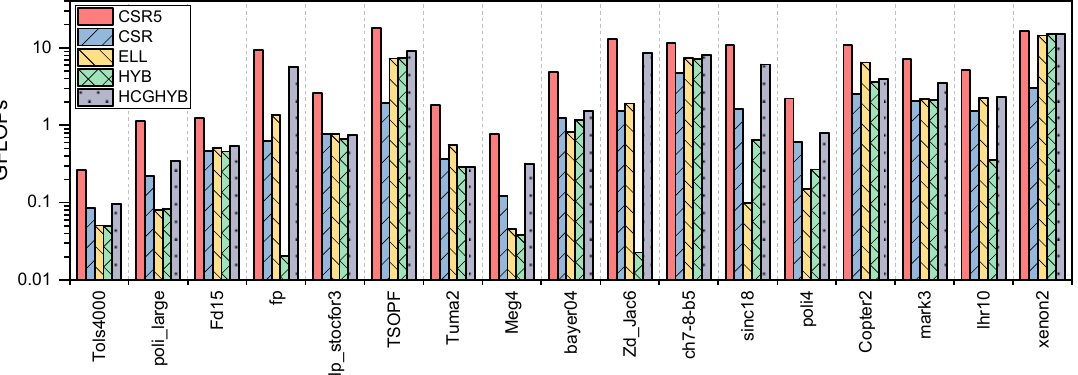
Figure 22. Heterogeneous CPU–GPU hybrid (HCGHYB) GPU throughput compared to CSR, ELL, HYB, and